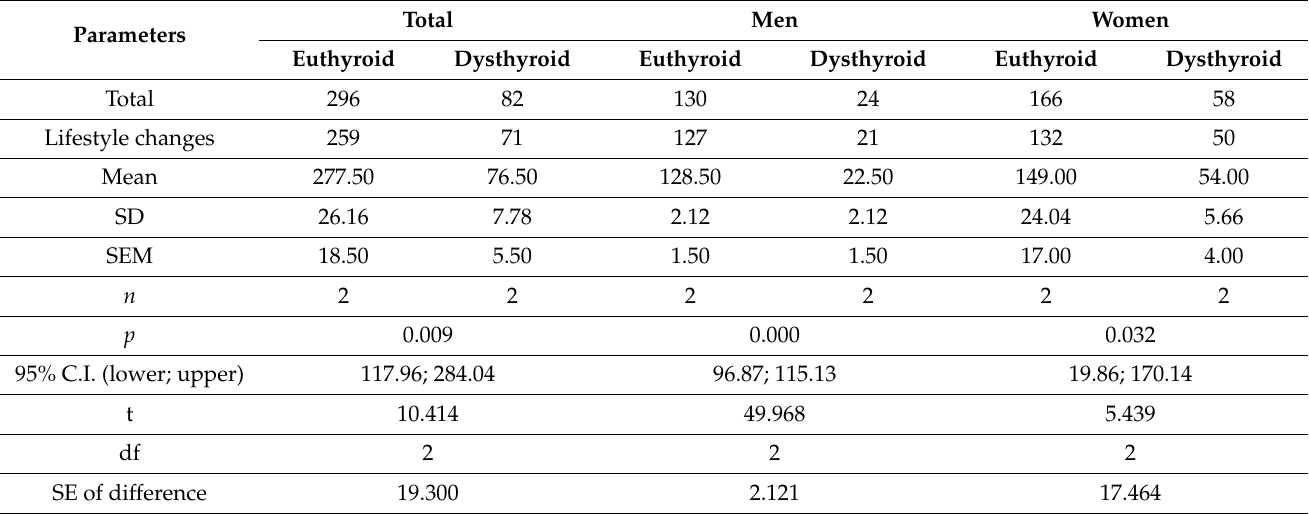
Table 5. Comparison between patients with euthyroidism and those with dysthyroidism regarding their lifestyle